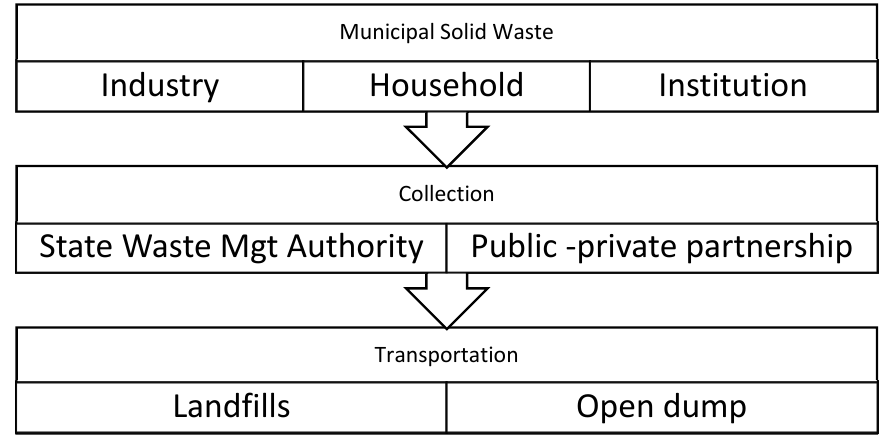
Figure 2. Current waste management framework in Nigeria.